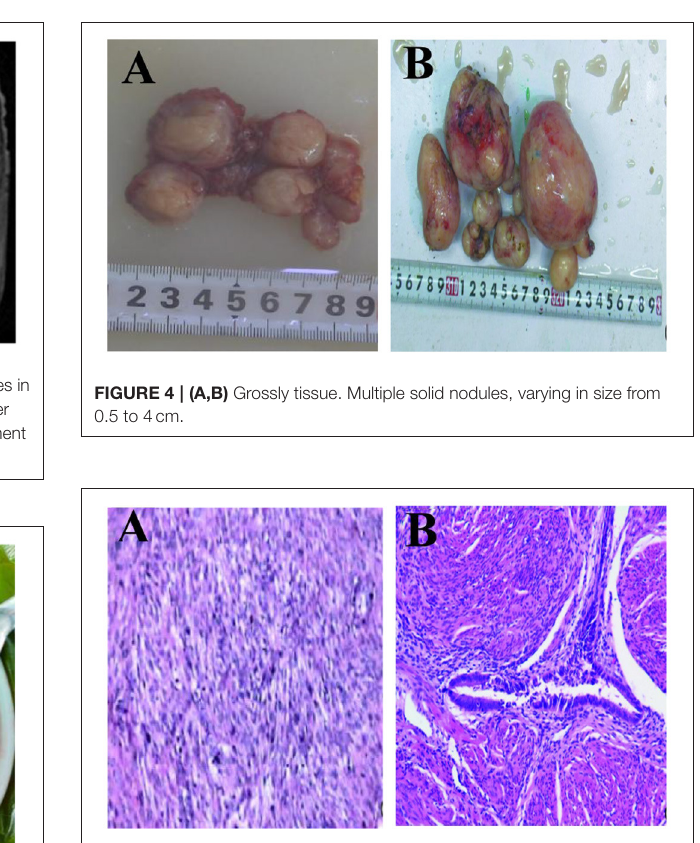
FIGURE 3 | (A,B) Lesions seen interoperation. (A) Obvious lesions in fat layer and fascia. (B) Lesions in the back wall and sacral ligament of the uterus.